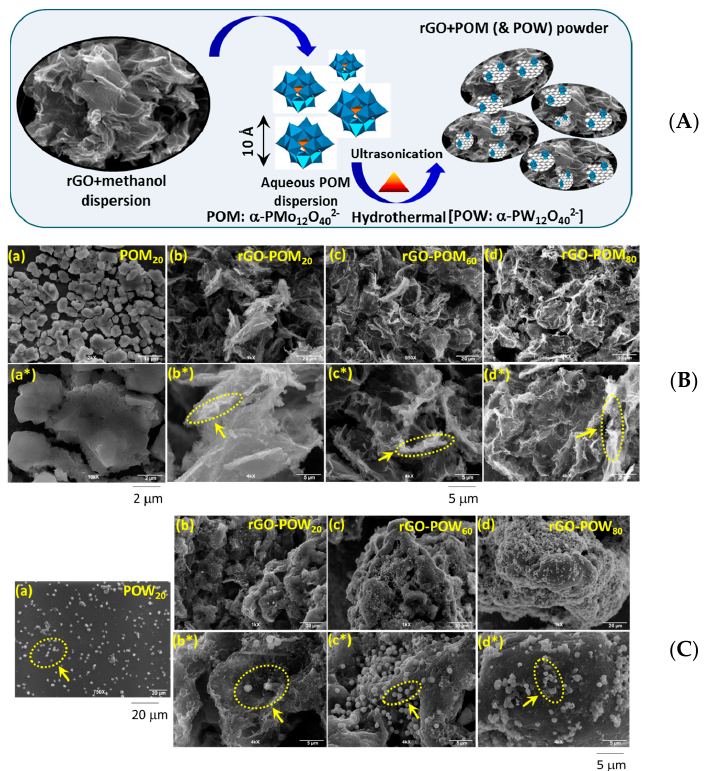
Figure 1. ( A ) Schematic illustration of hydrothermal synthesis for graphene-based “hybrids” with POM clusters and POW nanodots. SEM images of: ( B ) rGO-POM x ( a – d *); and ( C ) rGO-POW x ( a , b – d *) hybrid series ( x = 5, 10, 20, 40, 50, 60 and 80 wt %) revealing surface morphology and microstructure. (Scale bars are shown at the bottom of images).